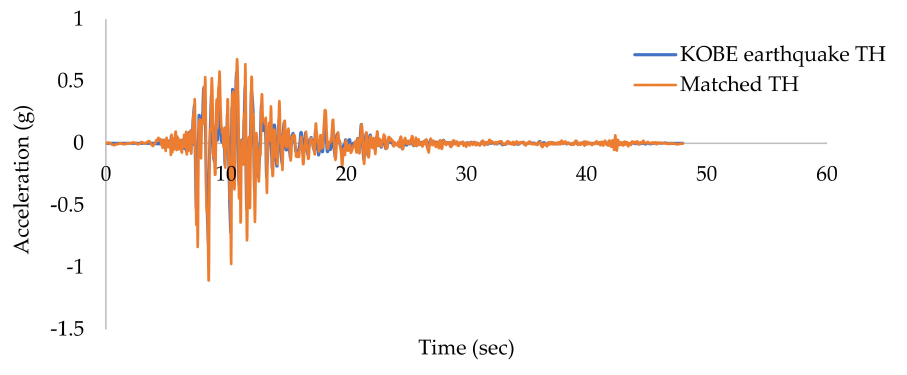
Figure 5. Kobe earthquake time history.